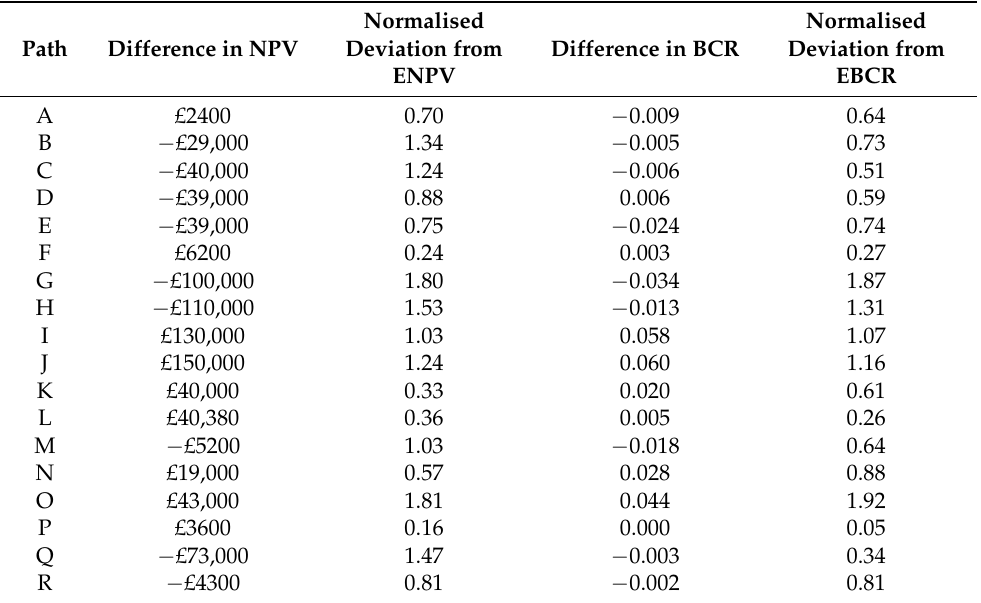
Table 6. Comparison of financial performance evaluated under uncertainty to the financial performance evaluated under the central deterministic scenario.